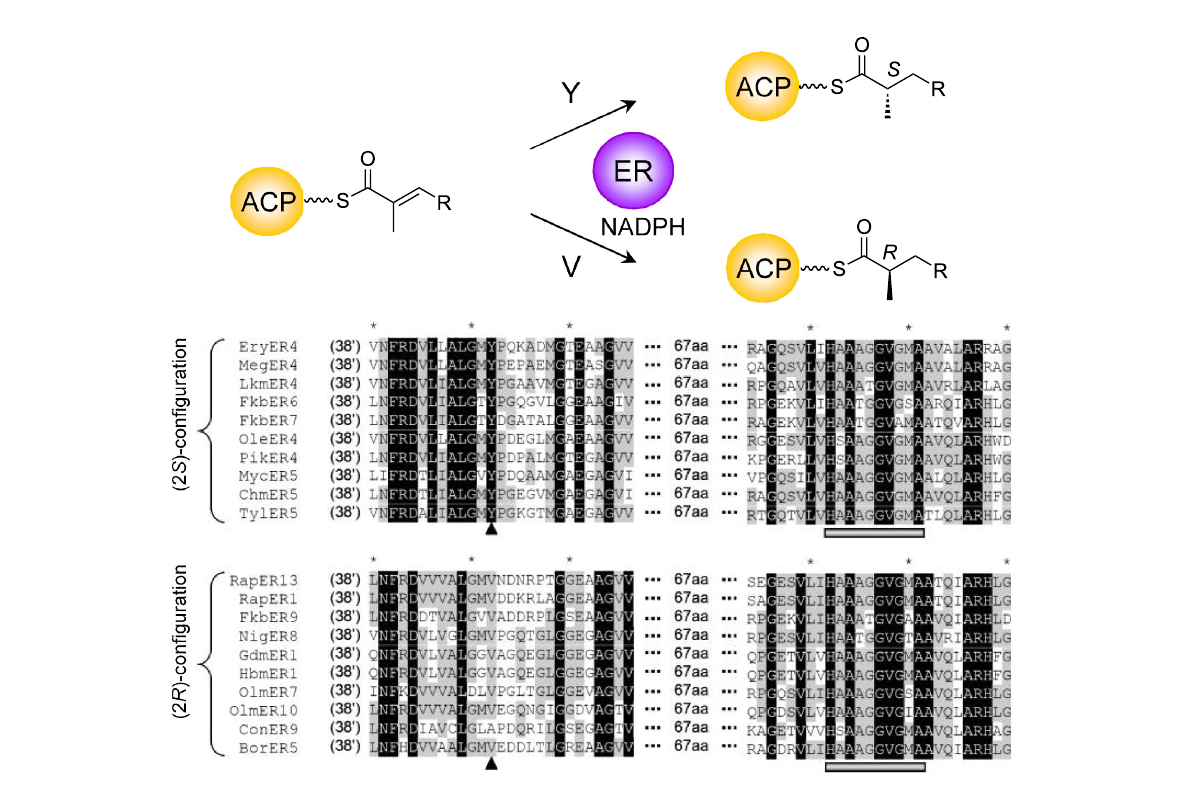
Figure 17: Stereocontrol by PKS ER domains. Sequence motifs correlated with the final stereochemistry of the C-2 methyl group [116]. When a conserved Y is present (indicated with the triangle), a (2 S )-methyl stereochemistry is observed, while the presence of a conserved V at the same posi- tion correlates with (2 R )-methyl stereochemistry. The grey bar indicates residues involved in binding the NADPH cofactor 12 . Residue numbering is based on that of E. coli QOR (PDB ID 1QOR). Reprinted and adapted with permission from [116]. Copyright (2010) American Chemical